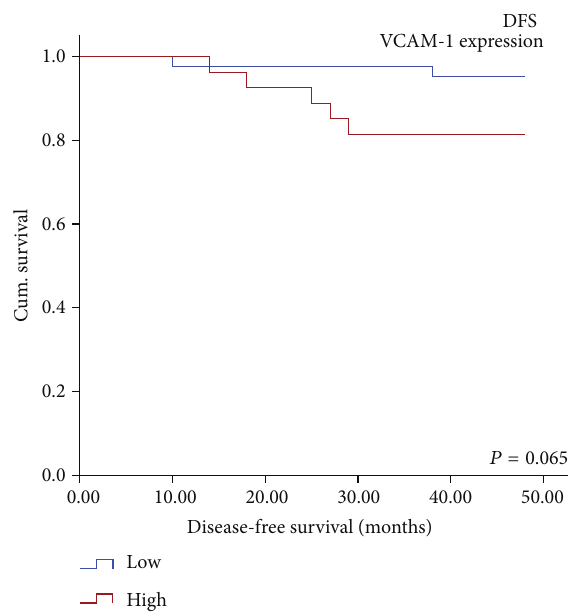
Figure7:ReducedDFSobservedinPTCpatientswithhighVCAM- 1 expression as compared to those having low VCAM-1 expression.